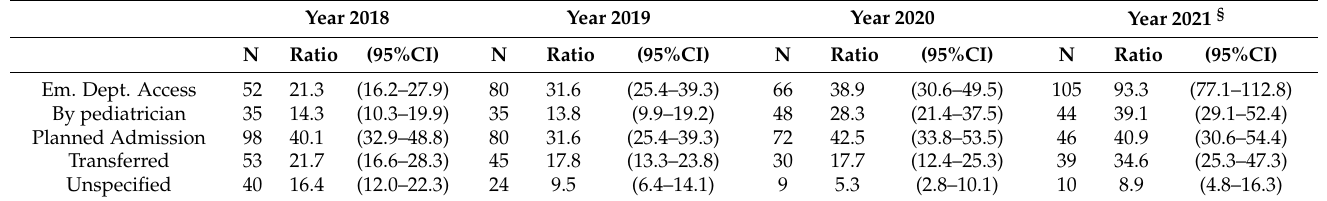
Table 3. Origin of hospitalization for EDs admission, absolute frequency, and ratio (with 95%